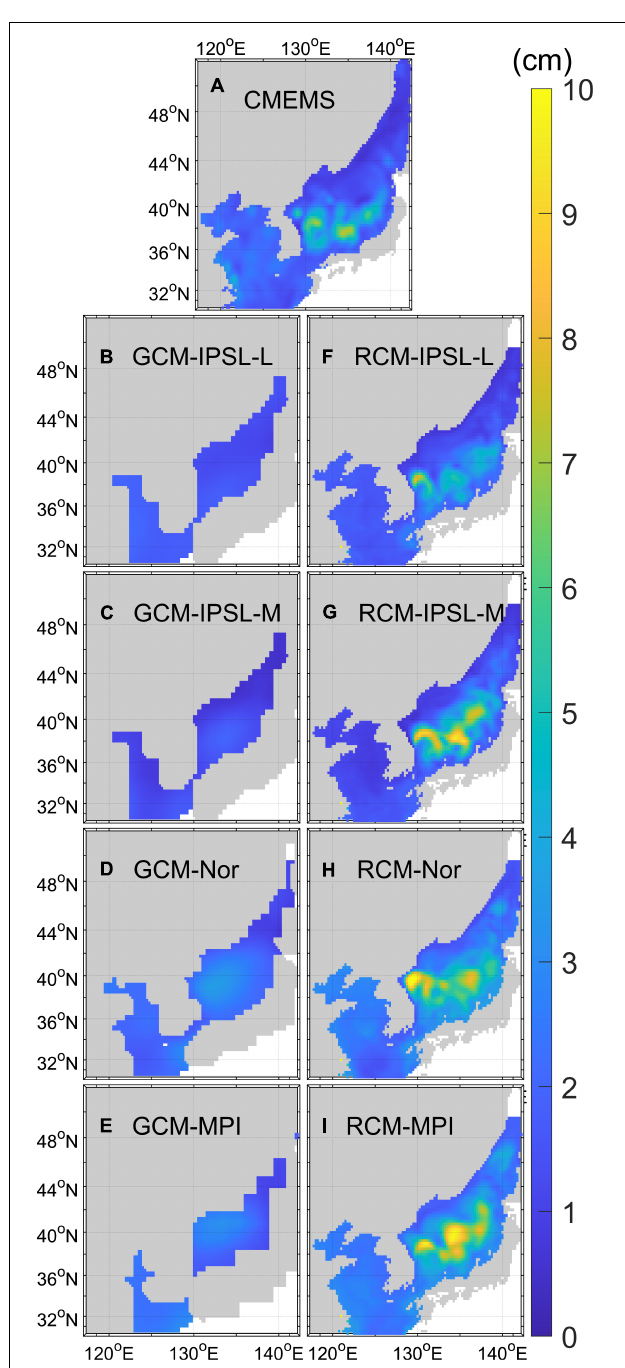
FIGURE 6 | Horizontal distribution of the standard deviations (unit: cm) for mean annual sea-level anomalies after removing linear trends, from: (A) CMEMS, (B–E) GCMs, and (F–I) RCMs,